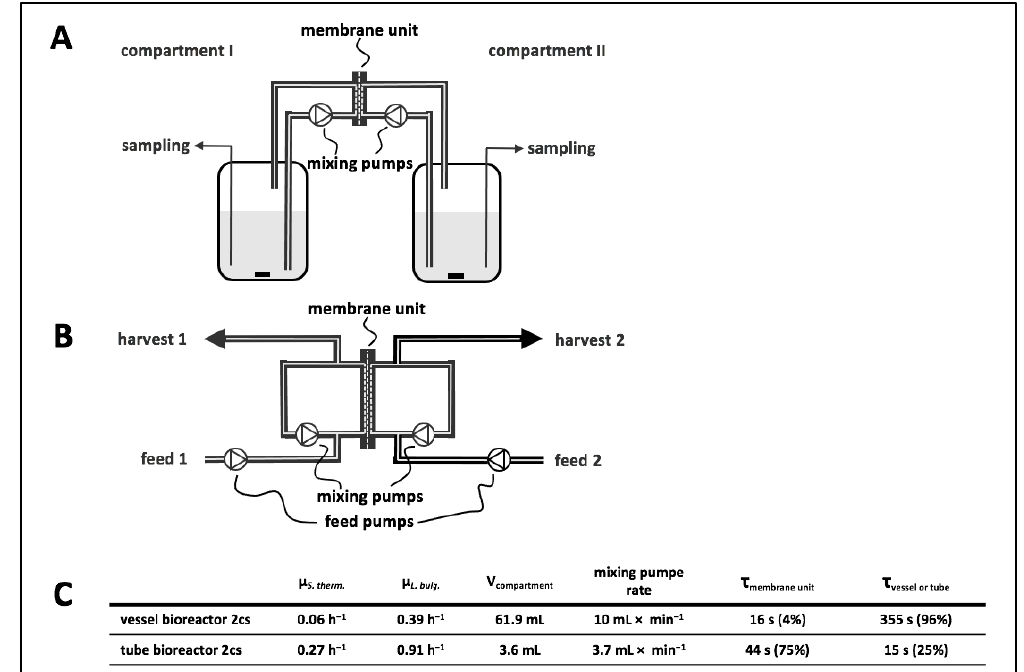
Figure 2. ( A ) Diagram of a vessel bioreactor system. The vessels were connected to the membrane unit, and circulation of medium in each compartment was achieved by mixing pumps. ( B ) Diagram of a tube bioreactor system. The inlets and outlets of the membrane unit were connected by tubes, and circulation of medium in each compartment was achieved by mixing pumps. Additionally, attached tubes for feeds and harvests allowed sampling and continuous cultivation by using feed pumps for each compartment. ( C ) Technical parameters and results of co-cultivations in respective two-compartment systems (2cs) with Lactobacillus delbrueckii subs. bulgaricus in synthetic medium (SM) containing casein and lactose and Streptococcus thermophilus in SM containing lactose. Strains were cultivated in co-culture in the 2cs, enabling exchange of metabolites, and strain-specific growth rates were determined from biomass measurements (Figures S4 and S5 in Supplementary Materi- als). V, volume.